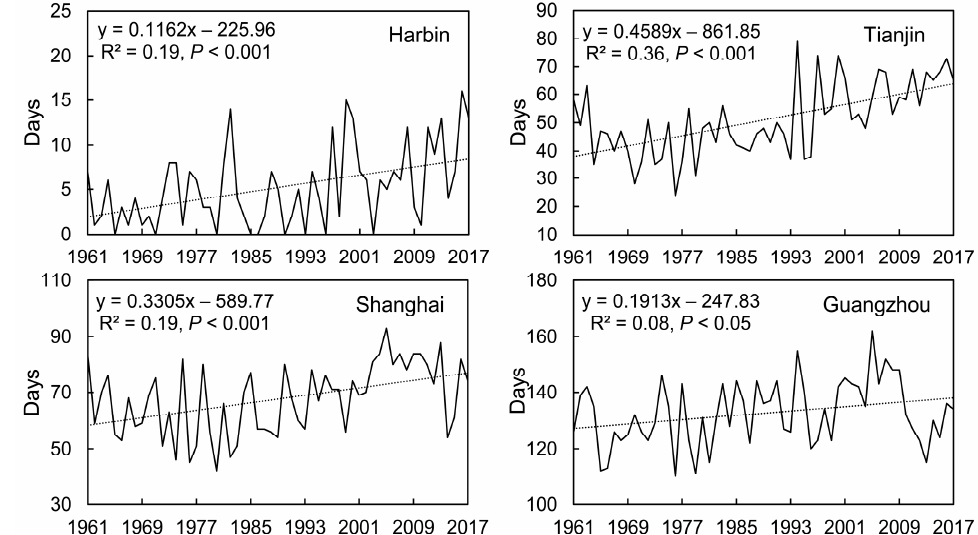
Figure 3. Changes in cooling degree days during the period of 1961–2017 for the four selected cities. There was no apparent change trend in the number of dehumidi fi cation degree days for Harbin, which belongs to the severe cold climate zone from 1961 to 2017 ( P > 0.1) (Figure 4). For Tianjin, Shanghai, and Guangzhou in the cold, hot summer and cold winter,